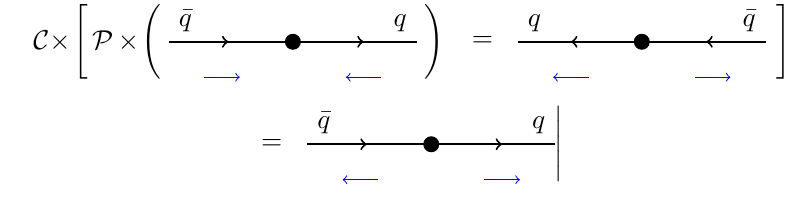
Figure 2 . Parity and charge transformations on the elementary ( −− ) amplitude. The lines on the arrows represent fermion flow, and the arrows below the lines represent the spin